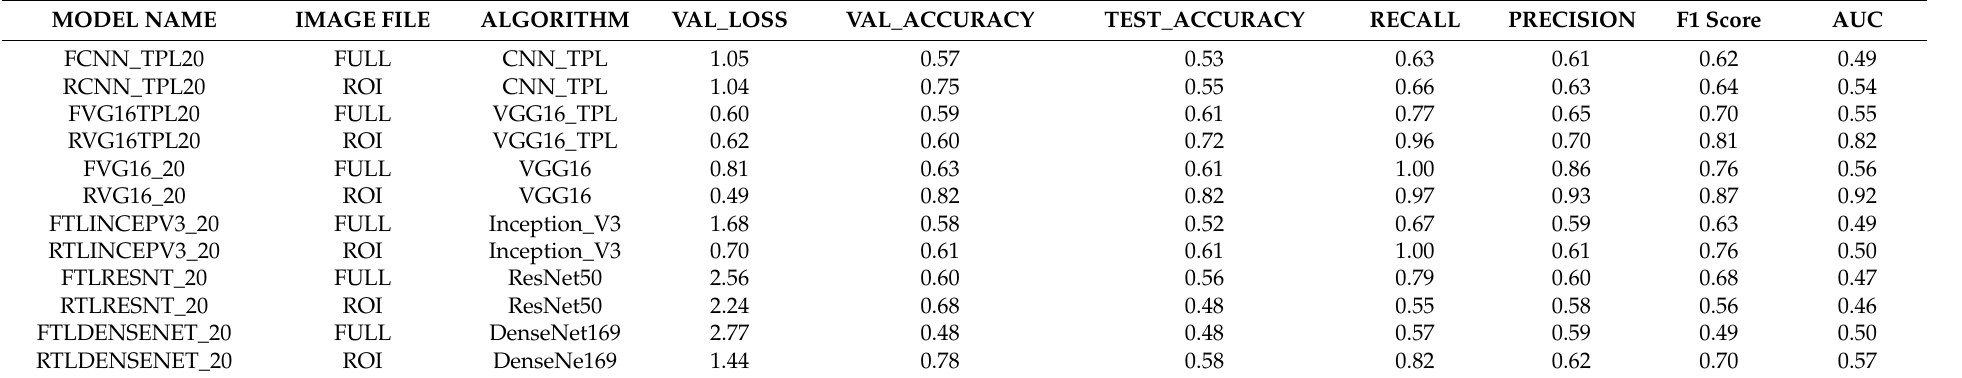
Table 2. Performance metrics used to assess the